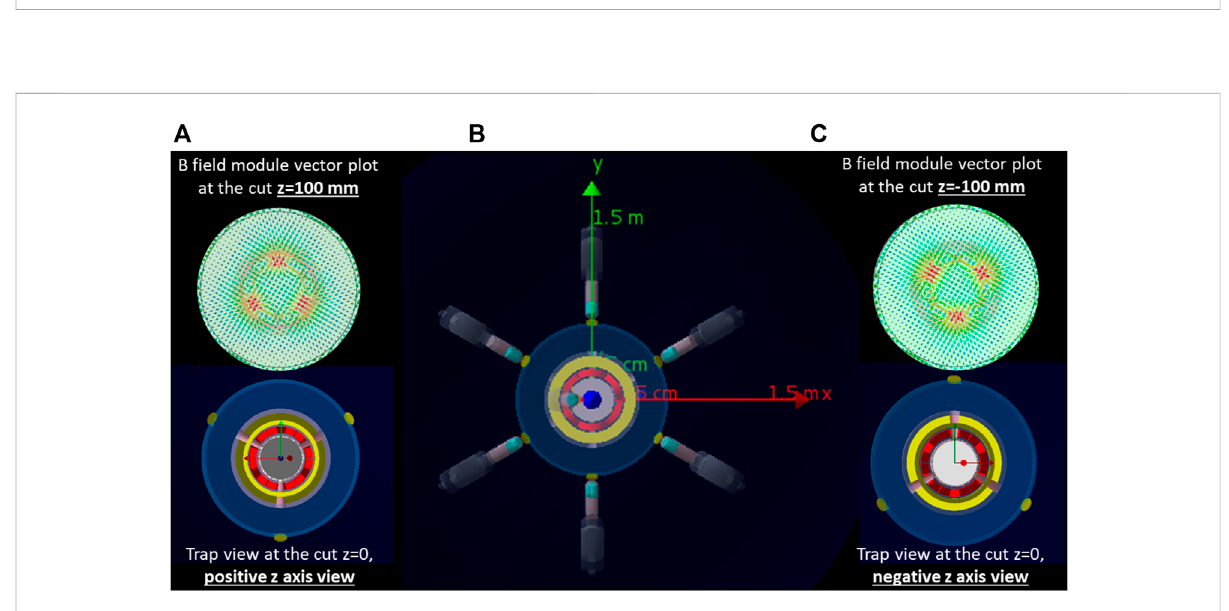
FIGURE 6 Sketch of the detector positions (B) compared to B fi eld lines distribution. Two cut views are shown in (A) for z = 100 mm and in (C) for z = − 100 mm. Each pair of HPGe (shown in the lower panels A and C) has been placed outside the regions where the magnetic fi eld lines are more intense (shown on upper panels A and